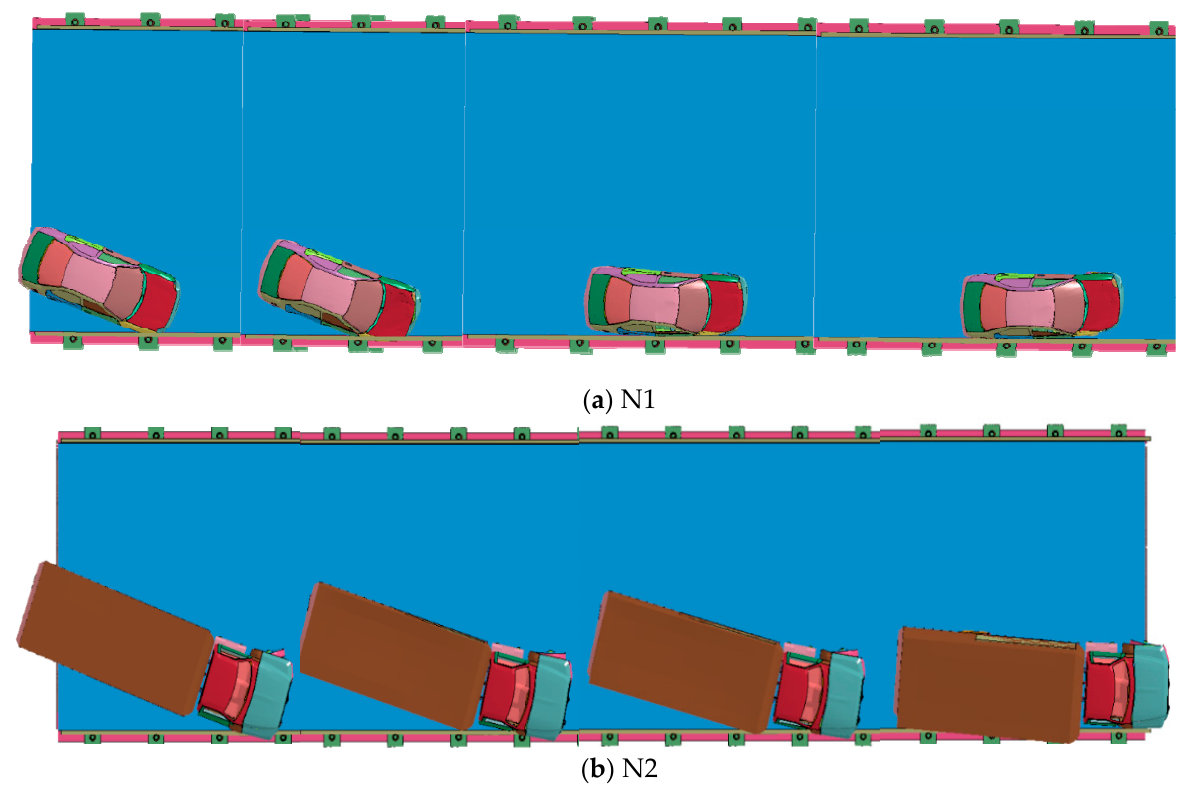
Figure 11. Snapshot of sample ( a ) N1, ( b ) N2 during collision. The X axis is the longitudinal direction of the guardrail while the Y axis is the lateral direction of the guardrail in Figure 12. Figure 12 shows the displacement–time curve of a point on the left seat of the car and a point on the truck seat in the x and y directions. Figure 12 shows the trajectory of the car and the truck. It can be seen from Figure 12 that the displacement of the car in the cross-bridge direction reaches a maximum value of 554.4 mm at about 0.165 s. After the car turns, the displacement gradually decreases in the cross-bridge direction. The cross-bridge displacement of the truck reaches a maximum of 780.15 mm at about 0.23 s, and then, the truck changes its